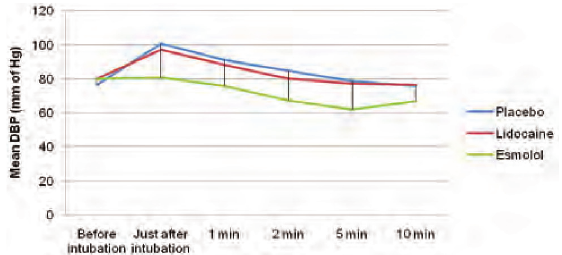
Figure 1: Comparison of mean systolic blood pressure in the study groups before and at different time periods after intubation